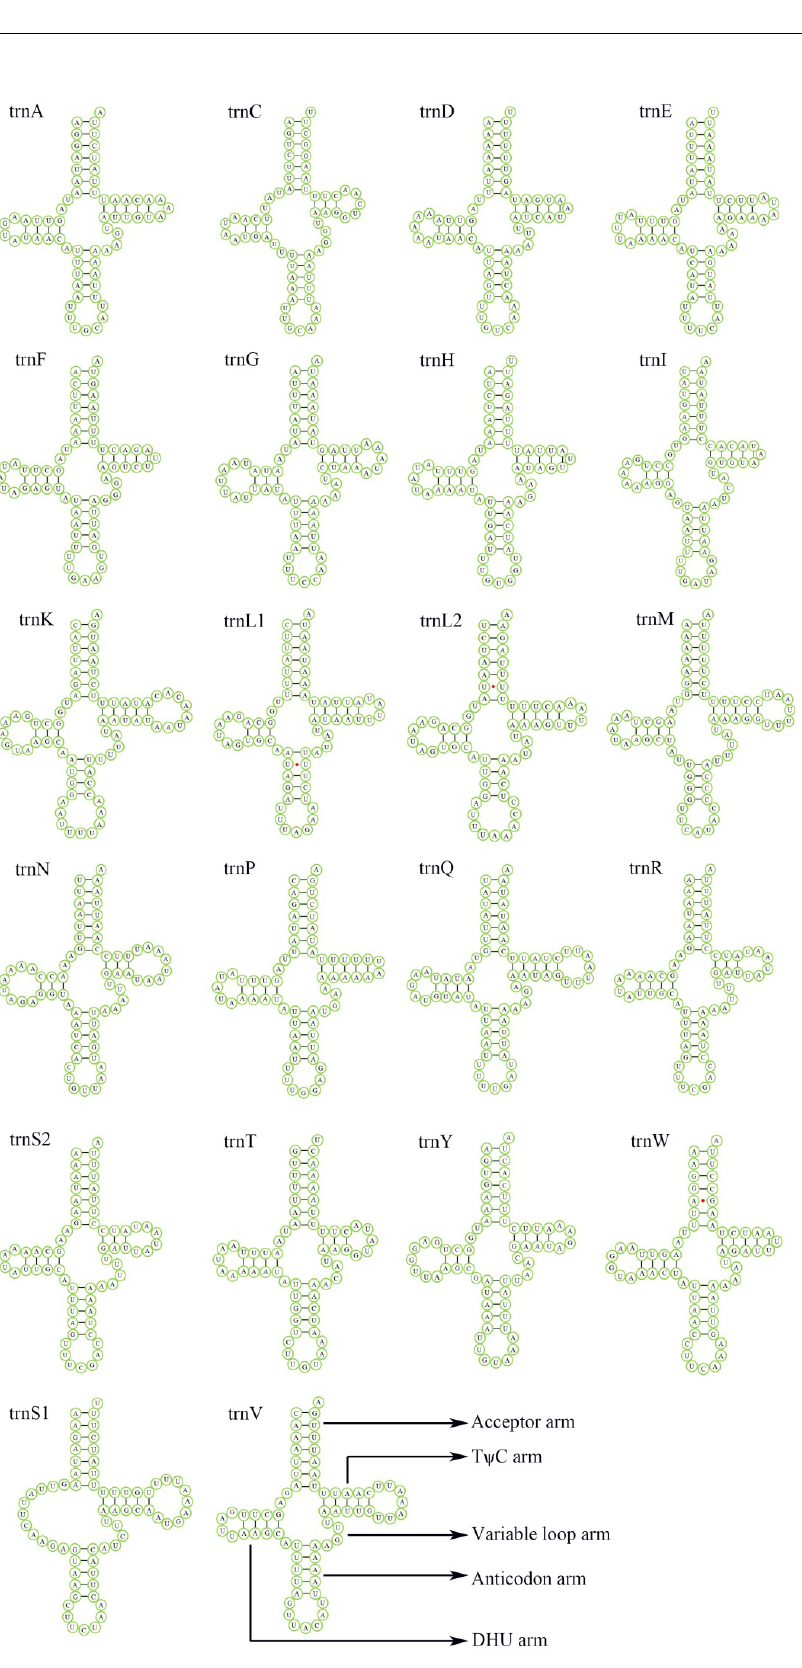
Figure 4. xxx Figure 4. Predicted secondary structures of 22 tRNAs in Luperomorpha xanthodera . Lines (-) indicate Watson–Crick base pairings, whereas dots ( • ) indicate unmatched base pairings. The uppercase letter indicate the identity of each tRNA genes. Structural elements in tRNA arms and loops are illustrated as for